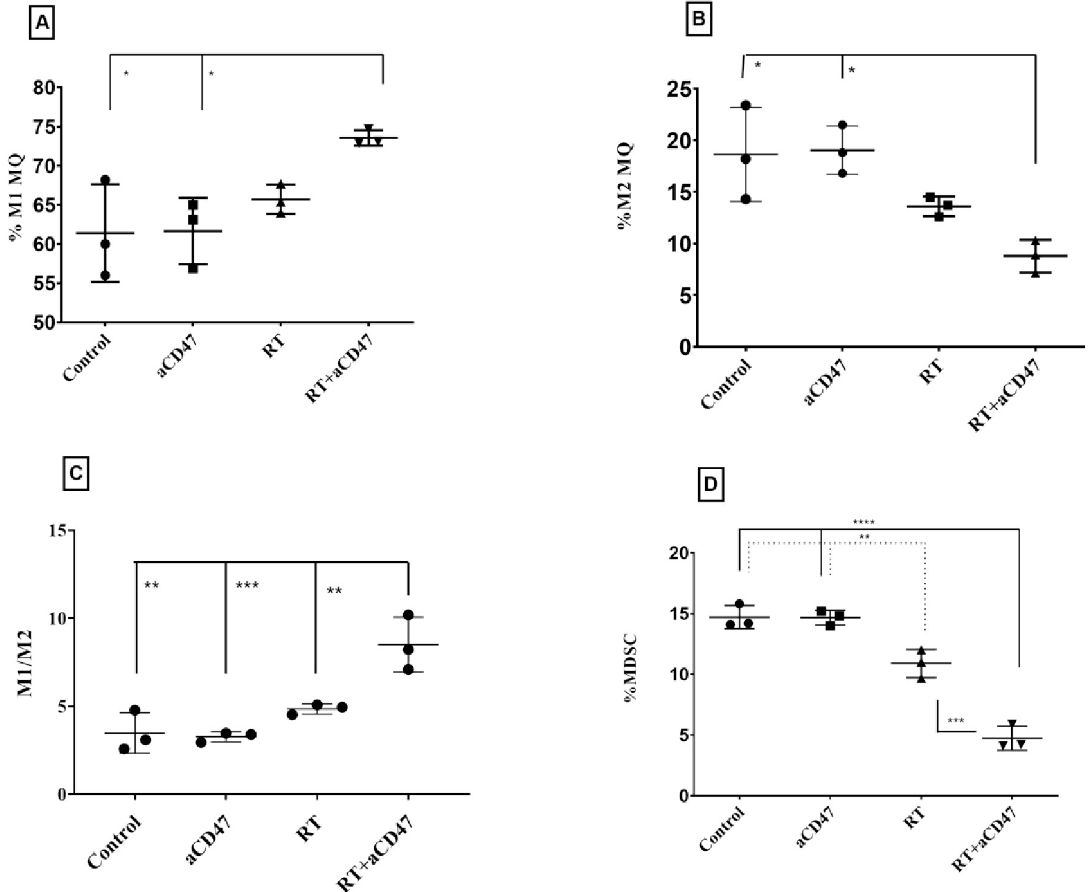
Fig 3. Ablative RT combined with α CD47 mAb altered the numbers of M1, M2 macrophages, and MDSC cells in TME. The percentage of CD45 + CD11b + CD80 + (M1 macrophages), CD45 + CD11b + CD206 + (M2 macrophages), and live CD45 + CD11b + Gr-1 + (MDSC) cells infiltrating into the tumor are presented respectively in ( A ), ( B ), and ( D ). The M1/M2 macrophage ratio is presented in ( C ) Data are displayed as the mean (SD) and were analyzed using the Tukey’s Multiple Comparison Test ( � : P < 0.05, �� : P < 0.01, ��� : P < 0.001, and ���� : P <